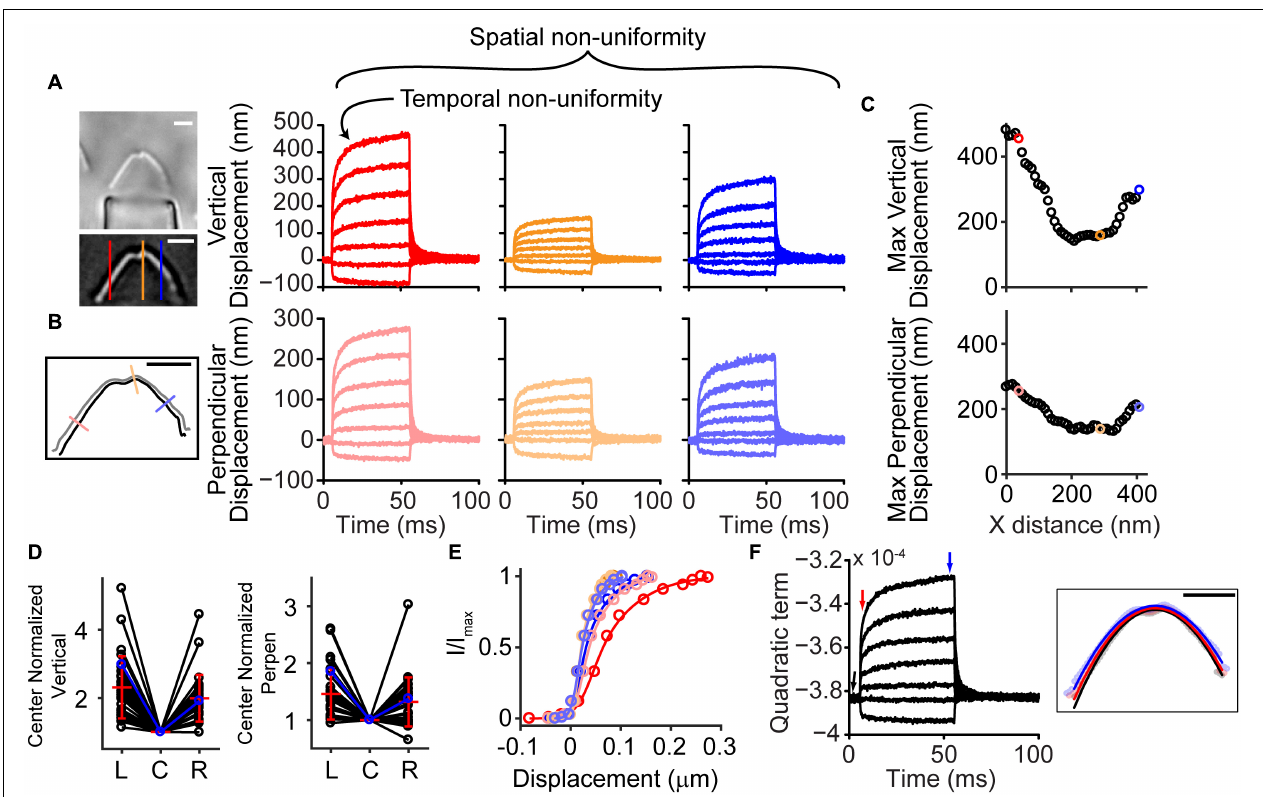
FIGURE 1 | Hair bundle motion was not spatially uniform with a fluid jet stimulus. (A) Hair bundle images show the raw image (top) and a filtered image used for analysis with colored lines indicating where the vertical motion was measured. Plots of the vertical hair bundle motion at three different positions along the hair bundle indicated differing movement magnitudes demonstrating the spatial non-uniformity. Within each displacement trace there was a temporal non-uniformity exhibited as a creep of the hair bundle. (B) Perpendicular hair bundle motion was calculated at different points along the hair bundle (colored lines) and showed different movement magnitudes. The image showed the resting position of the hair bundle in black, with the position at the end of the force step shown in gray. Corresponding displacements along the perpendicular lines are color coded. (C) Maximum ending displacements for the cell in panels (A,B) as a function of x distance along the hair bundle, indicating that the positions toward the sides of the hair bundle move a greater distance. (D) Summary of 29 cells analyzed showing the center normalized movement of the left (L), center (C), and right (R) side of the hair bundle for the vertical and perpendicular directions. The cell in panel (A–C) is highlighted in blue. (E) The possible resulting activation curves due to the motion at different parts of the hair bundle indicated that the parameters differed more than 2x depending on where and how the motion was measured. Activation curves were generated with the displacement at the time of the peak current. (F) Fitting a quadratic equation to the hair bundle position in each frame indicated changes in the hair bundle width that follows a similar time course as the motion in panel (A,B) and further confirmed the larger movements toward the hair bundle sides. Right schematic shows the position of the hair bundle at each point along the hair bundle (circles) and the resulting quadratic equation fit (lines). Different colors represent different times when the hair bundle position and quadratic fits were obtained according to the colored arrows in the graph. Scale bars = 2 µ